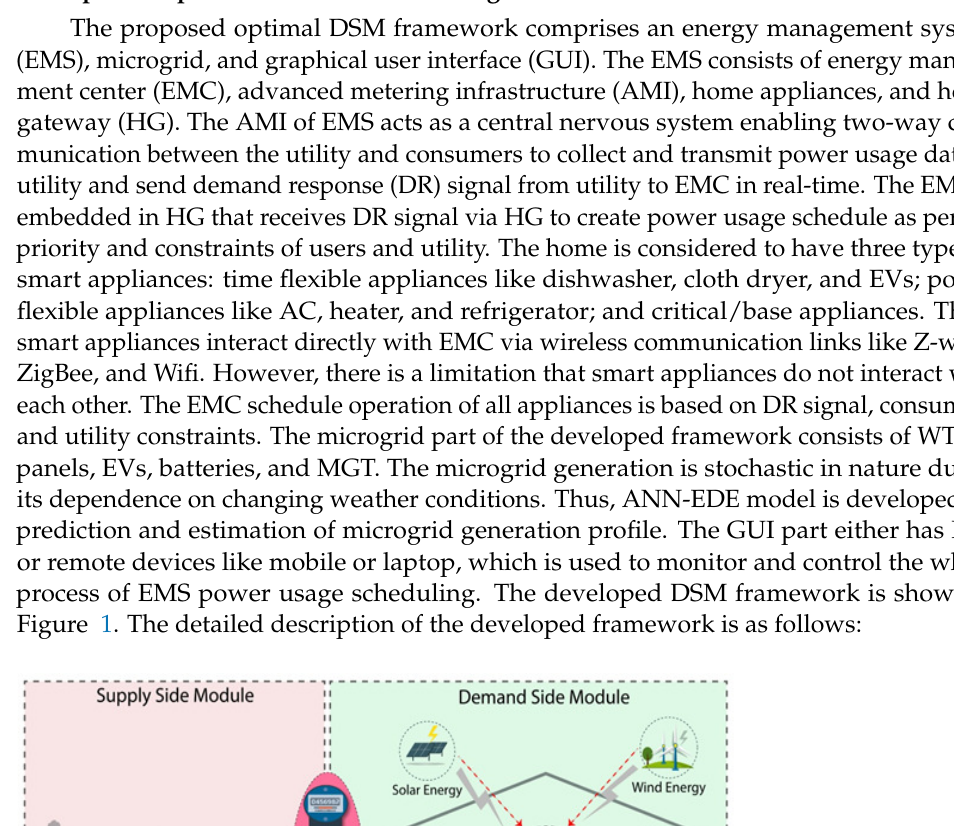
Figure 1. The detailed description of the developed framework is as follows: